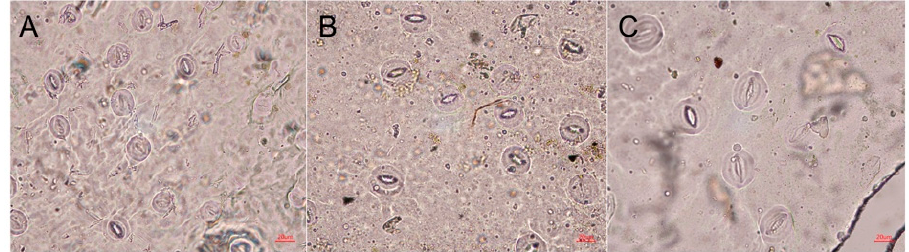
Figure 6. Stomata of diploid, tetraploid, and octoploid plants of R. fortunei . ( A ) Stomata of a diploid plant. ( B ) Stomata of a tetraploid plant. ( C ) Stomata of an octoploid plant. Scale bar = 20 µ m. Table 4. Stomatal characteristics of polyploid and diploid R. fortunei plants.